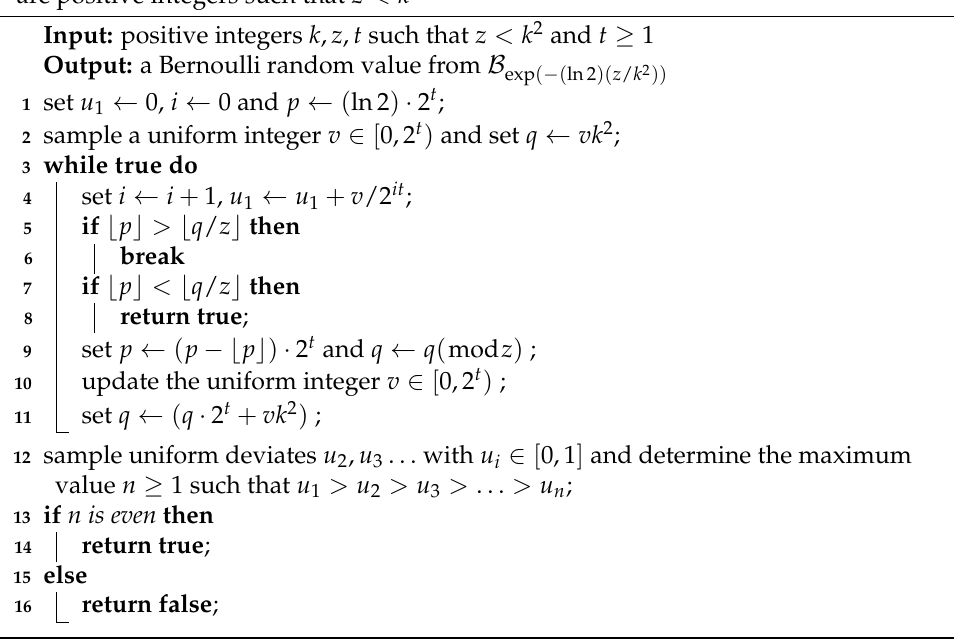
, where k , exp ( − ( ln2 )( z / k 2 ))